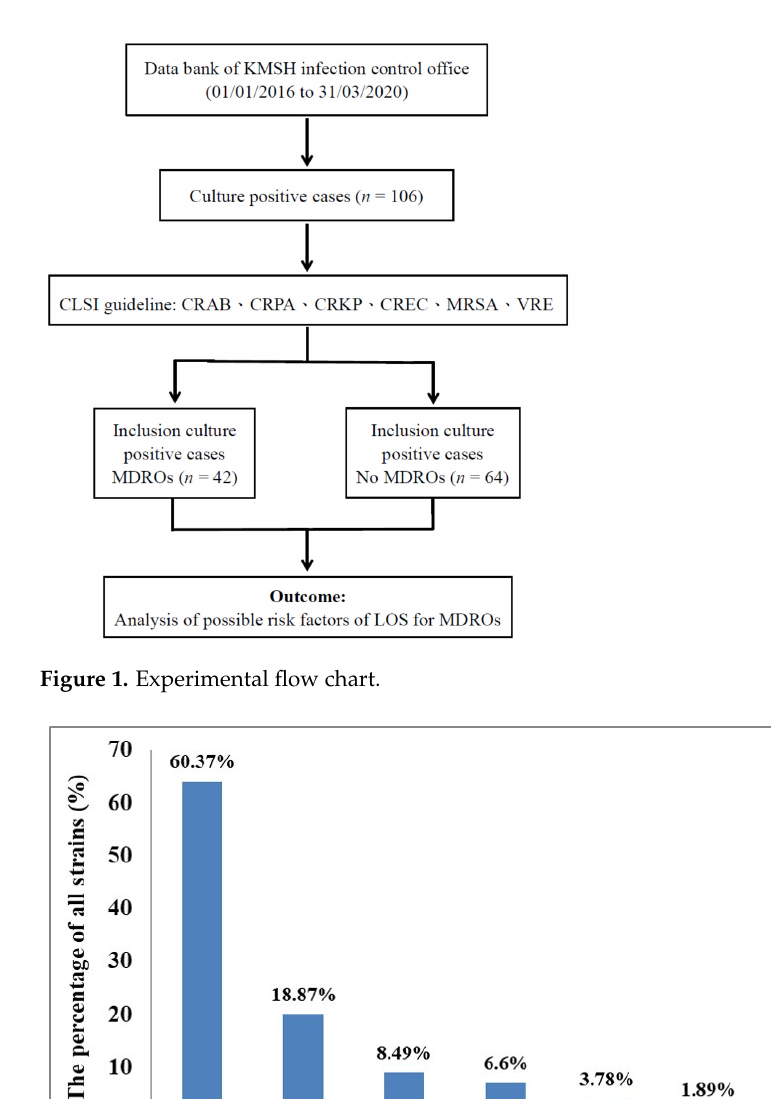
Table 1. Descriptive statistical analysis of risk factors.